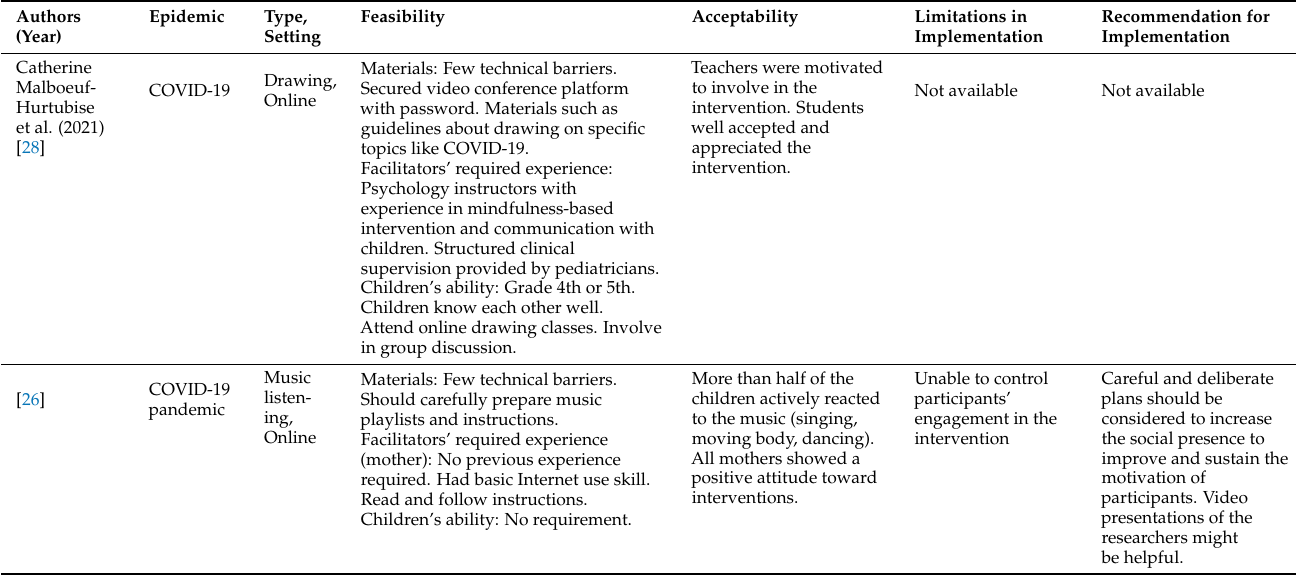
Table 2. Qualitative synthesis for feasibility, acceptability, and limitations in selected